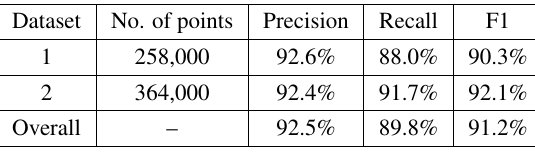
Table 1: Segmentation quantitative evaluation